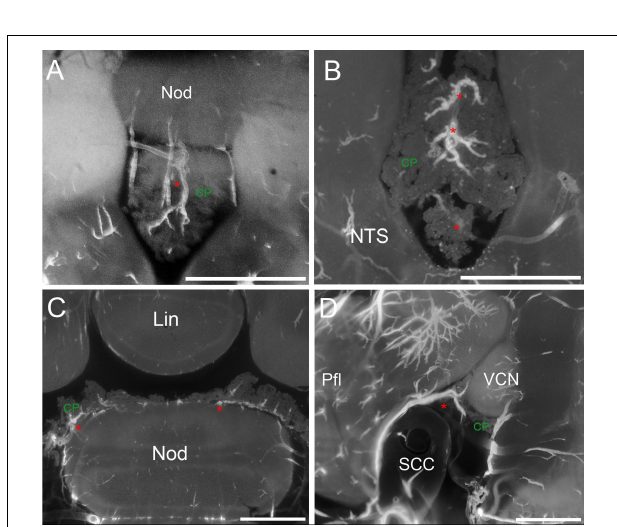
FIGURE 6 | CP arteries. (A) Z-stack maximal projection over 90 µ m z-range (3 µ m steps) showing arteries (red asterisk) penetrating the RSS. (B) Z-stack maximal projection over 50 µ m z-range (5 µ m steps) showing the star-like pattern of arteries entering the CSS. (C) Single optical slice showing CP “mounds” around arteries in the MHS and RSS. (D) Z-stack maximal projection over 90 µ m z-range (3 µ m steps) slices showing the artery (red asterisk) penetrating the MHS lateral side from the subarcuate fossa of the paraflocculus. Pfl, paraflocculus; SCC, semicircular canal, VCN, ventral cochlear nucleus. Scale bars: 1 mm. Signal: autofluorescence and